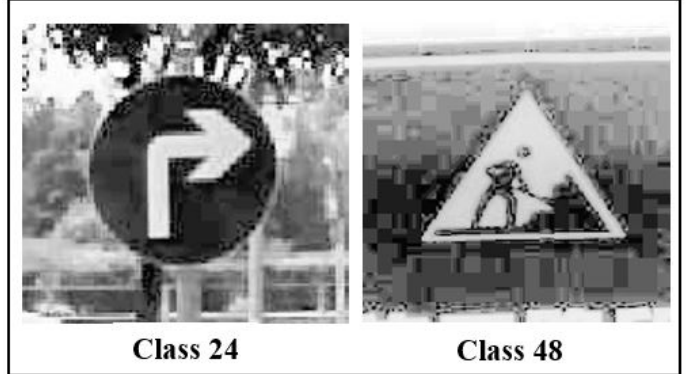
Figure 12. Misclassified classes of 24 and